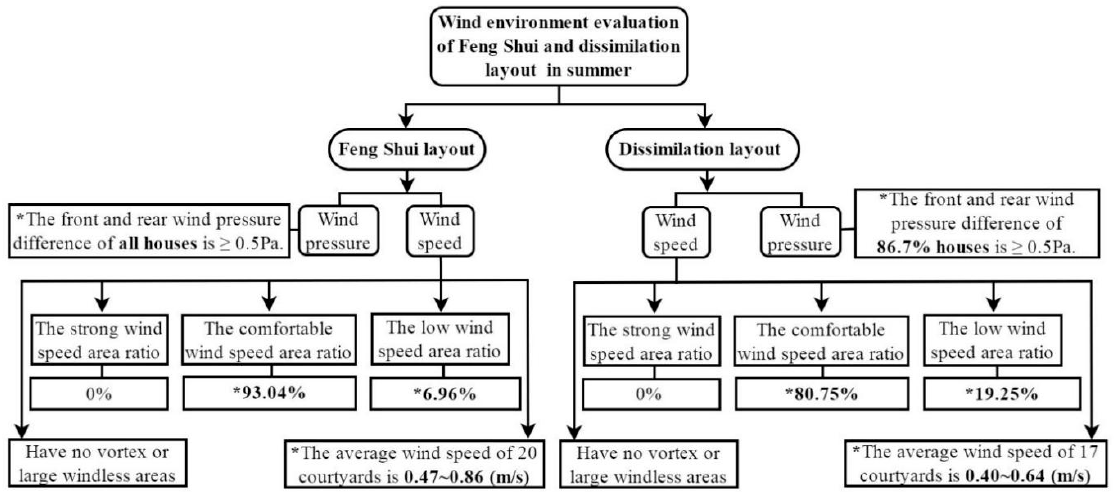
Figure 14. Outdoor wind environment evaluation of the feng shui layout and the dissimilation layout in summer (items with * mean that there is a big difference between the two layouts).